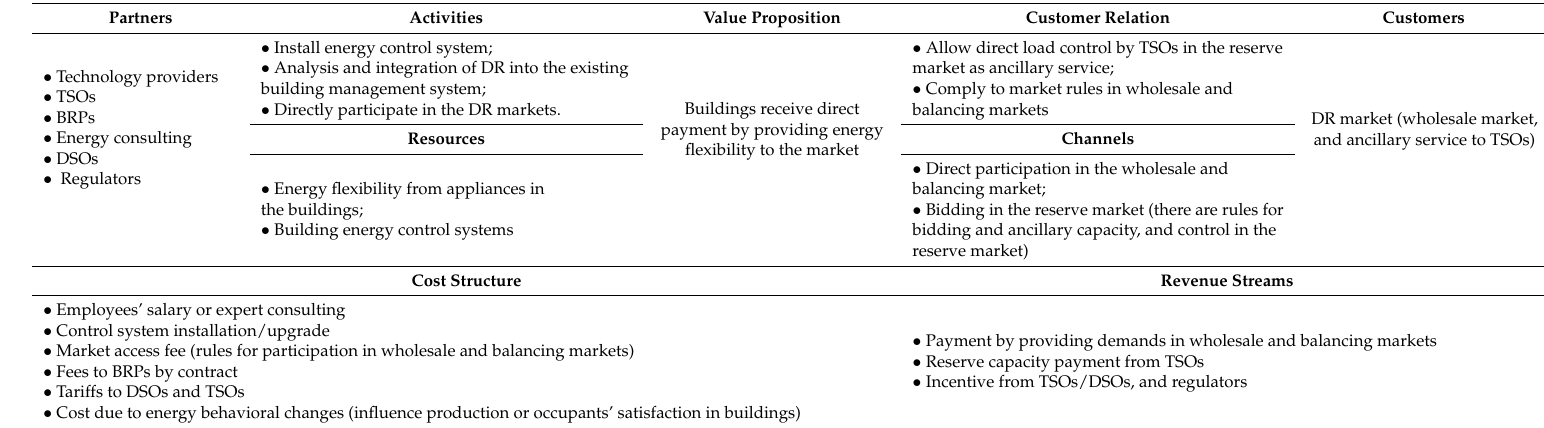
Table 9. Business Model 3- buildings directly access the explicit DR program.